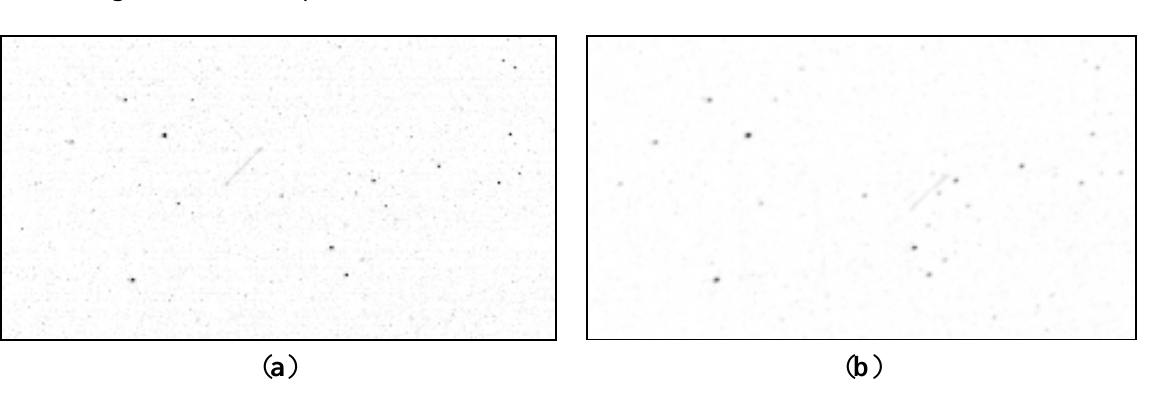
Figure 7. The foreground ( a ) and the background ( b ) images for satellite detection in the left image of the stereo